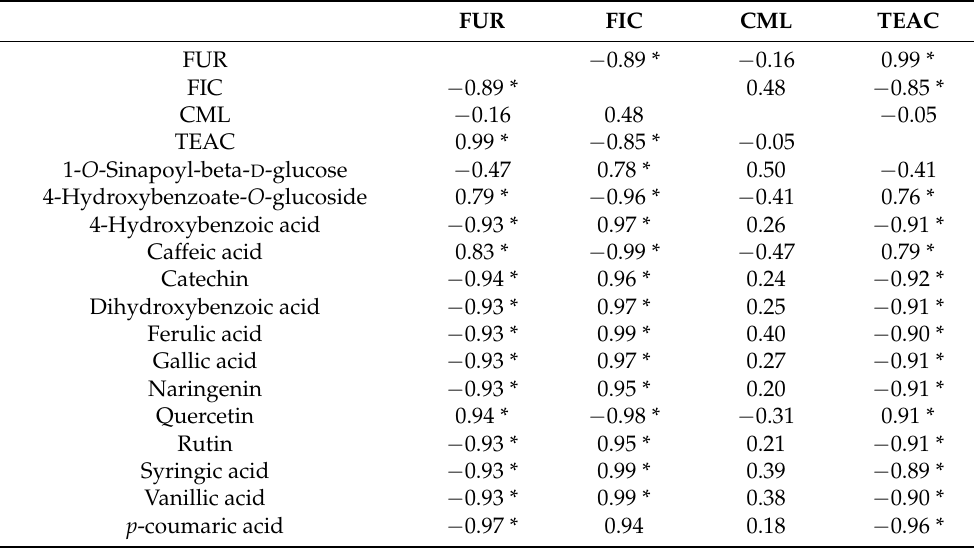
Table 3. Correlation coefficients between MRPs, phenolic compounds and antioxidant activity for raw and roasted buckwheat